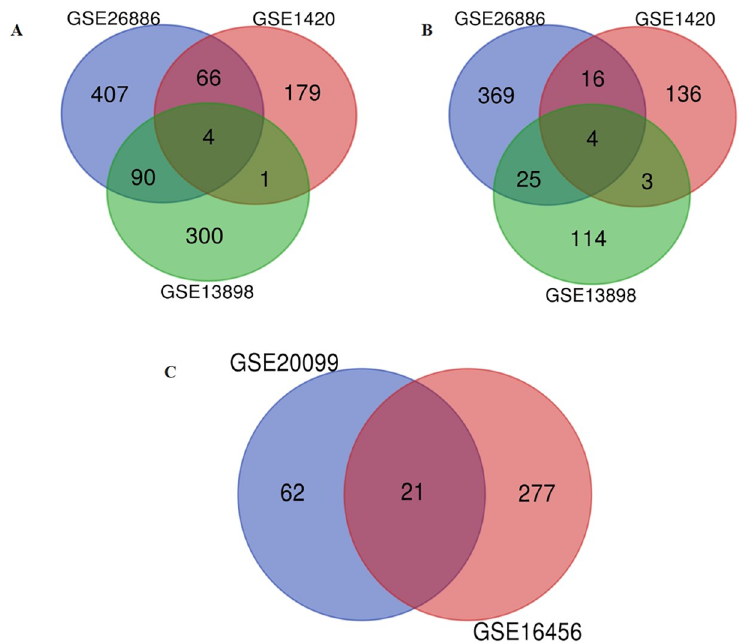
Fig 2. Identification of differentially expressed miRNAs (DEMs) and genes (DEGs). (A)Identification of downregulated DEGs; (B)Identification of upregulated DEGs; (C)Identification of DEMs.